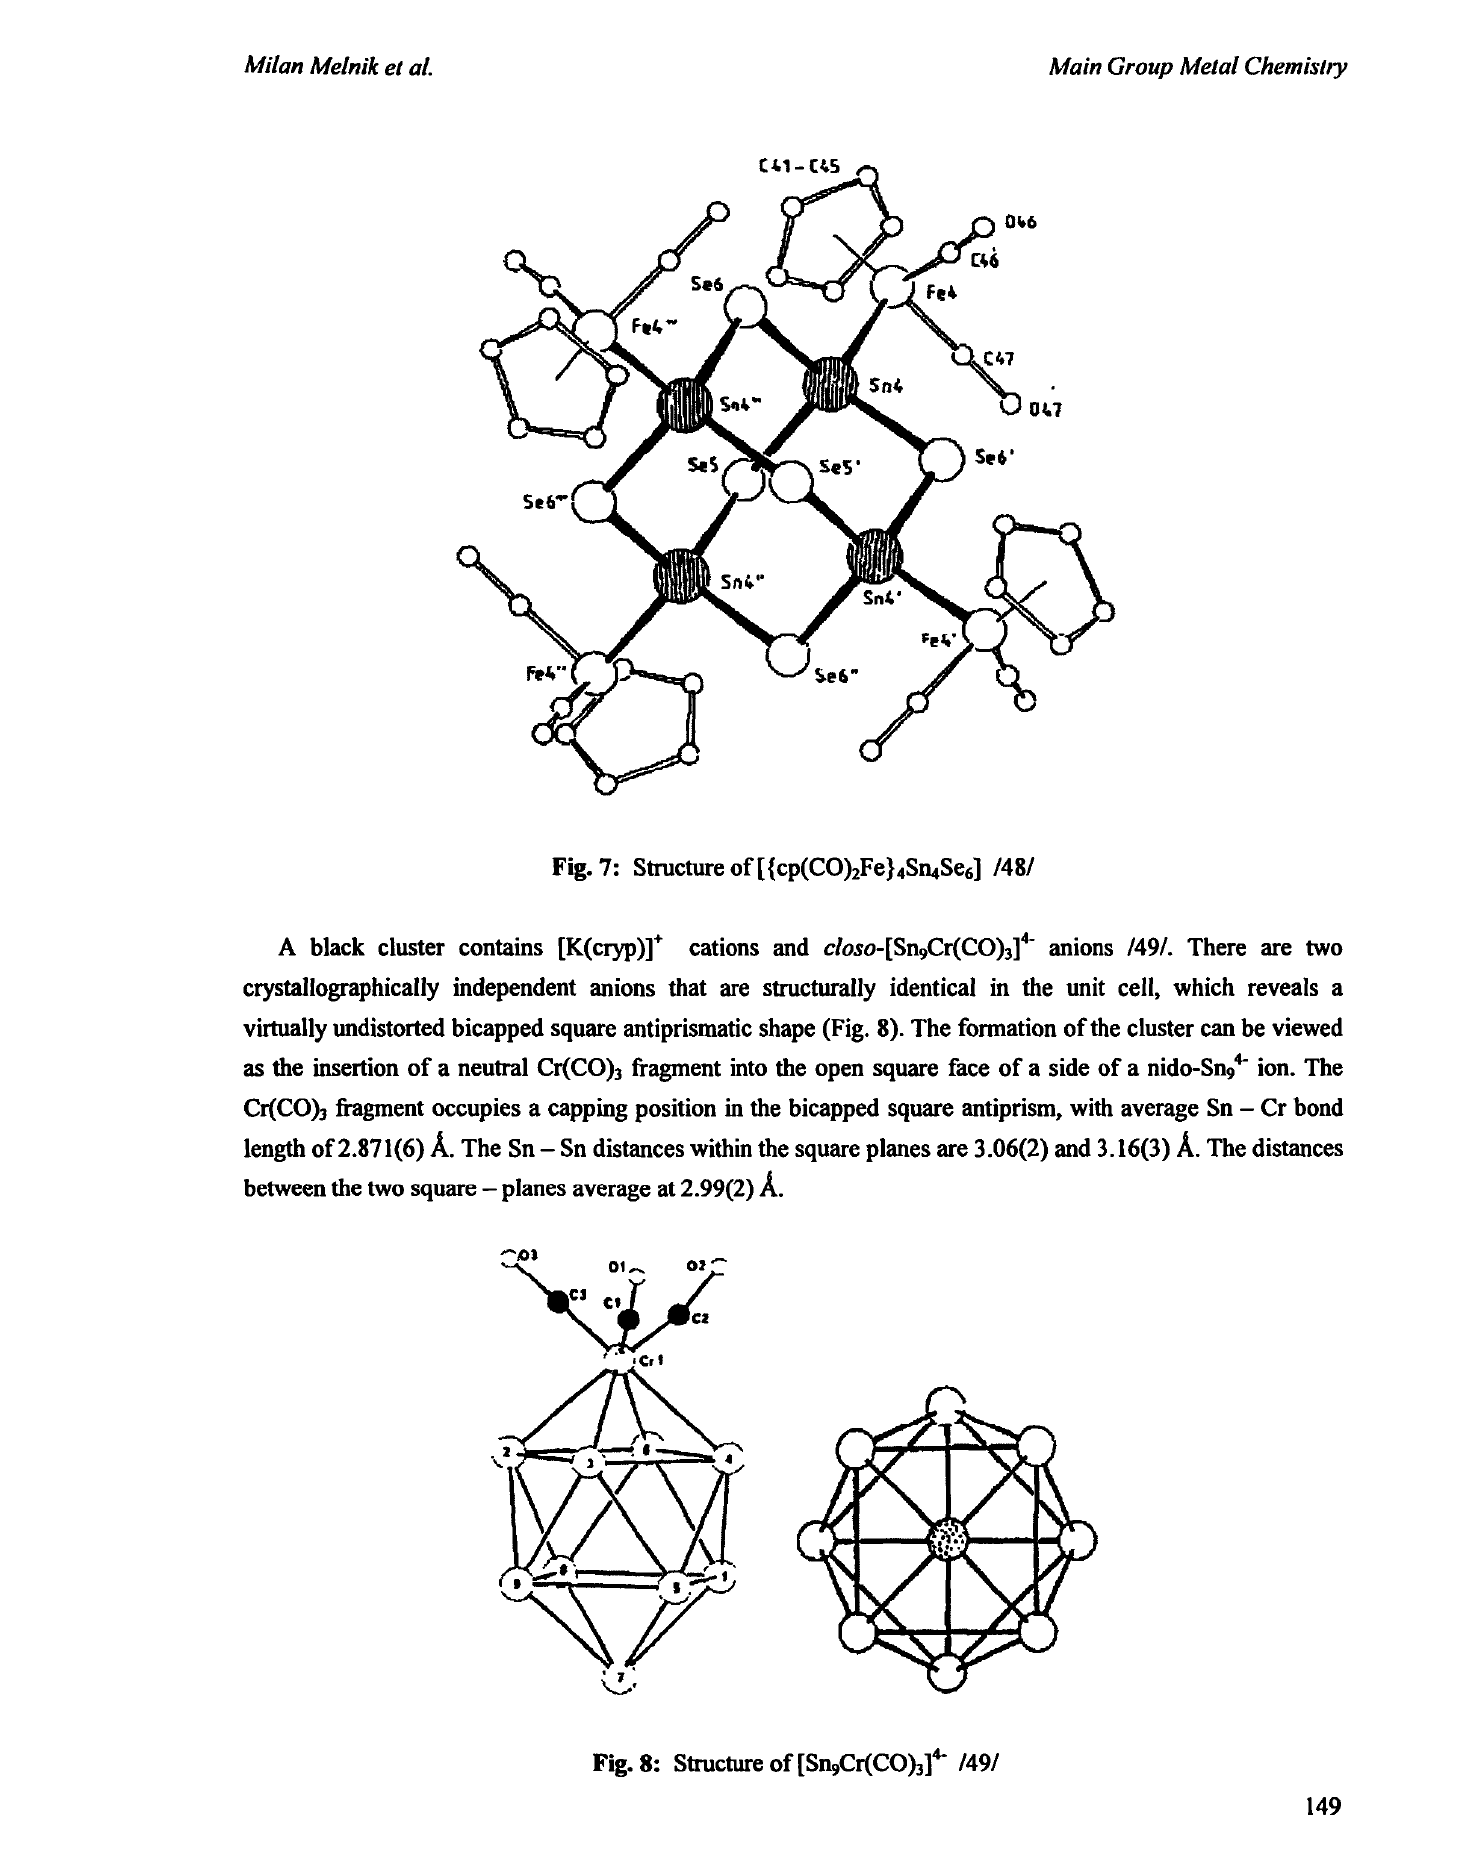
Fig. 8: Structure of [Sn,Cr(CO)3] 4 ·